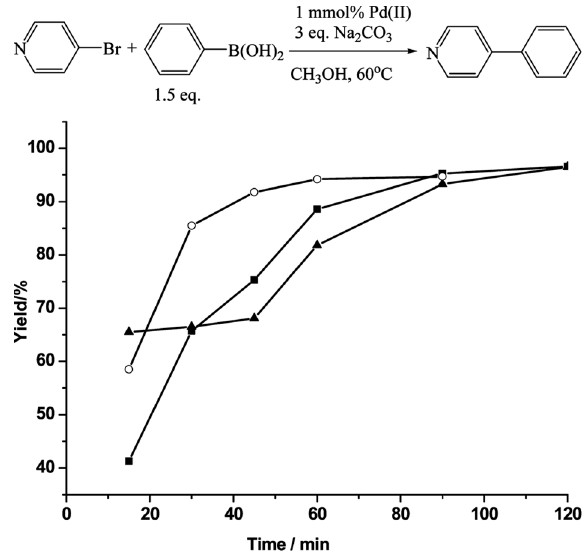
Figure 2. Suzuki ‐ Miyaura coupling of 4 ‐ bromopyridine and phenylboronic acid (catalyst: circles, 1:1 gel; triangles, 1:2 gel; squares, 1:4 gel). Reproduced with permission from Reference [56].